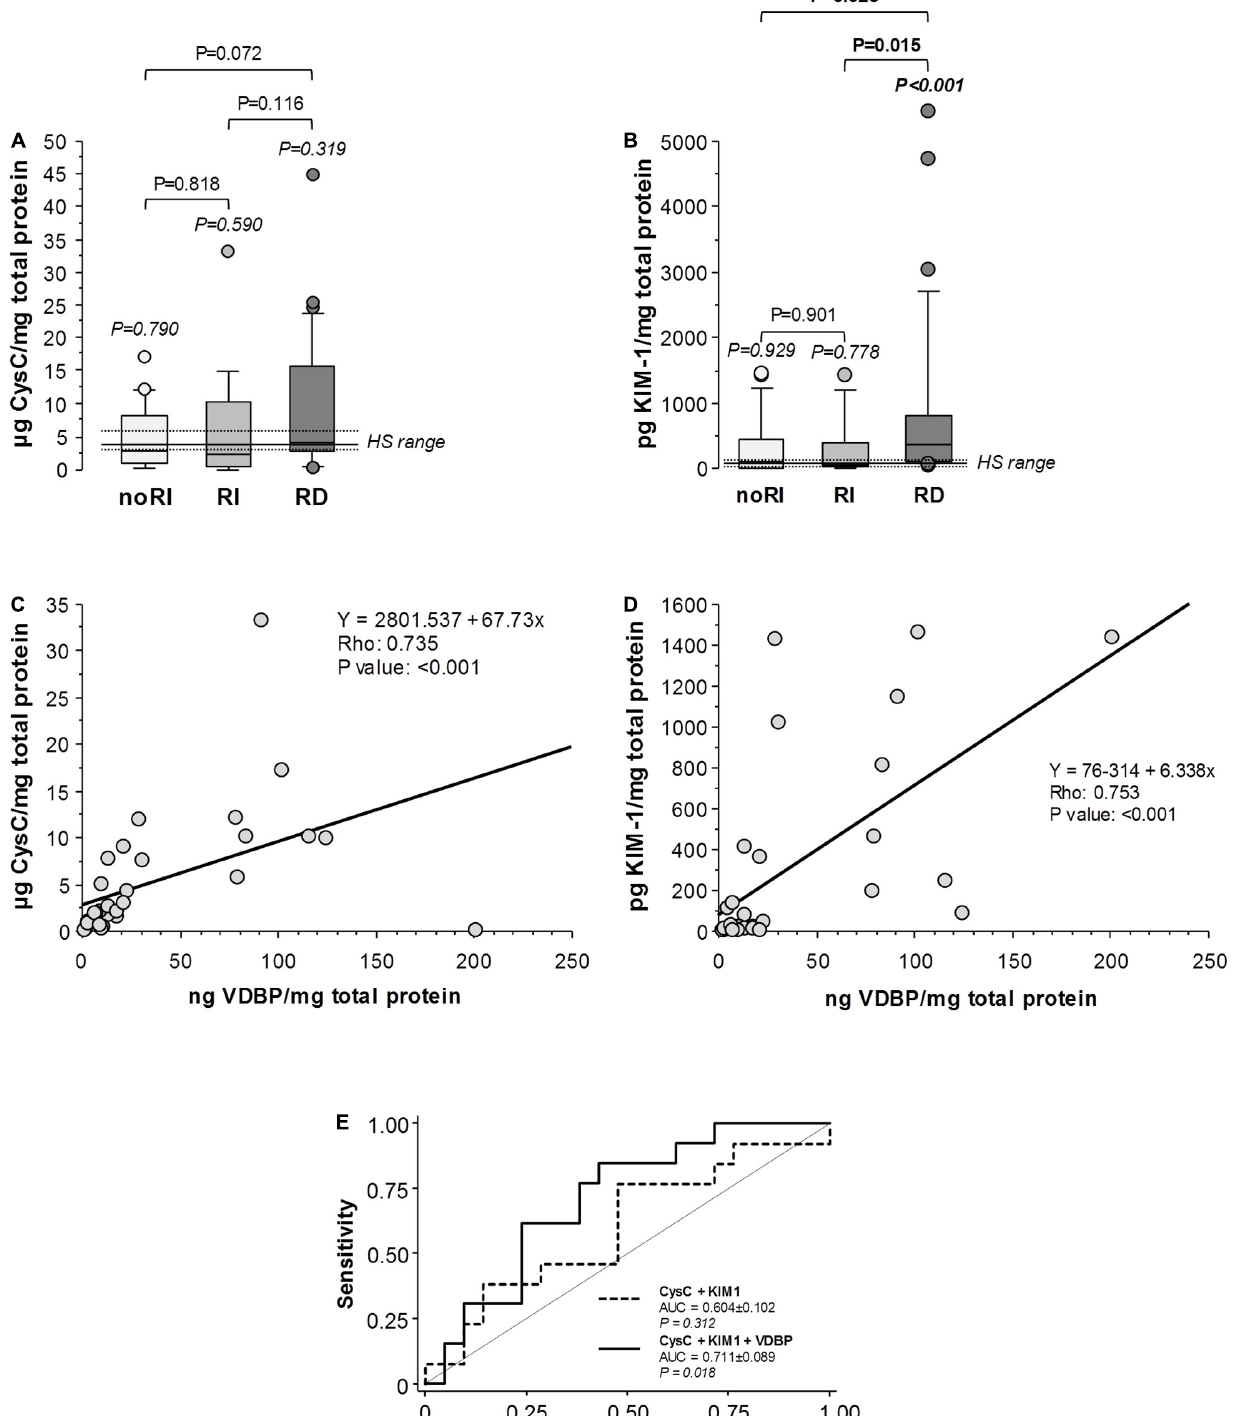
Frontiers in Cardiovascular Medicine |